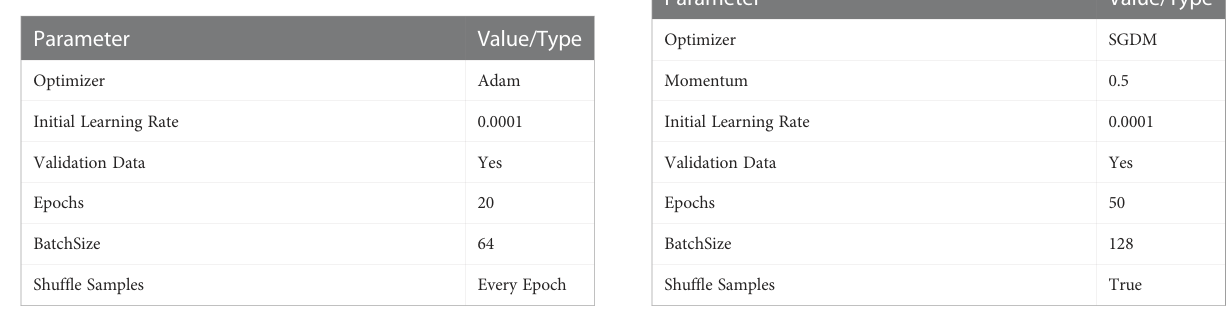
TABLE 3 List of hyper parameters used for training plant leaf lesion semantic segmentation model.